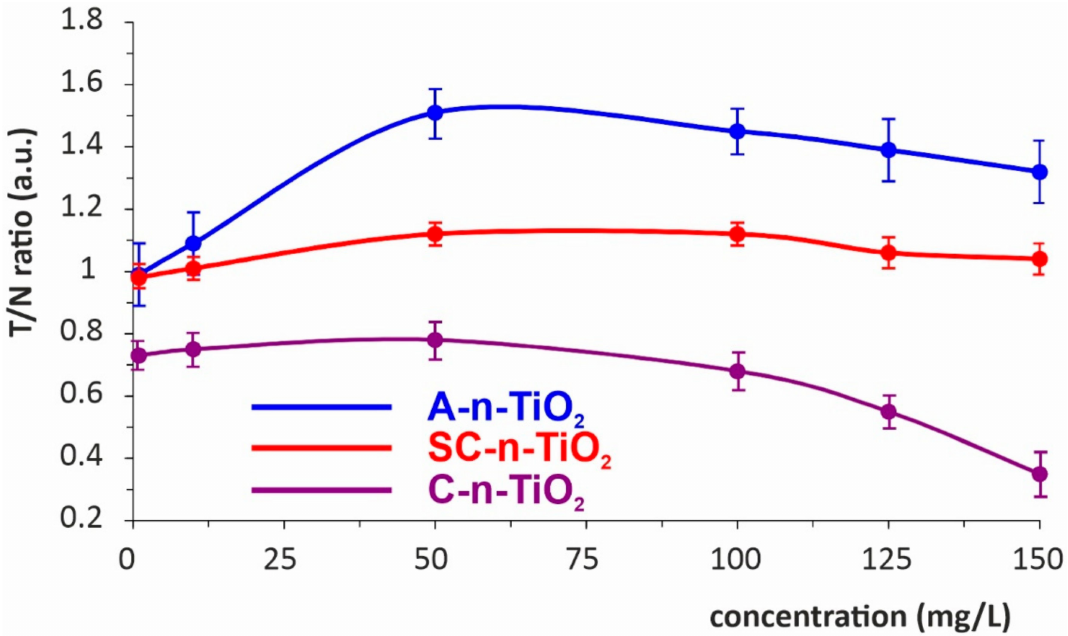
Figure 4. The concentration-dependent photoprotective effect of n-TiO 2 on fibroblast cells irradiated with UVB. The cell viability was assayed with MTT test and expressed as the ratio of viable cells treated with n-TiO 2 to the not treated control (T/N), both of them irradiated with